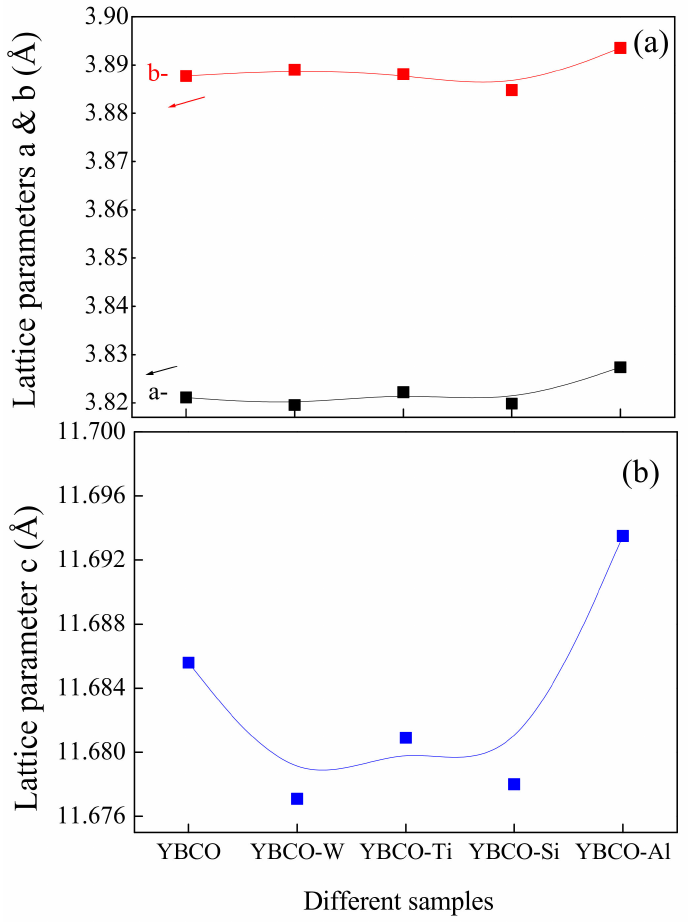
Figure 2. ( a ) Variations of the lattice parameters ‘a’ and ‘b’ for different ceramics. ( b ) Variations of the lattice parameter ‘c’ for different ceramics.